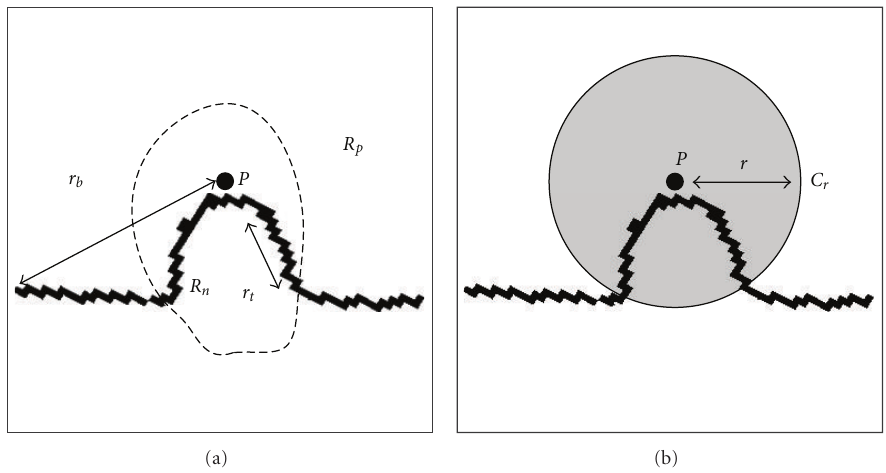
Figure 7: (a) Model of region of interest, with nodule subregion indicated by the dotted line and (b) region excluded for pleural point subset selection, indicated by gray-shaded circle (all surface points outside the circle, C r , are in the selected